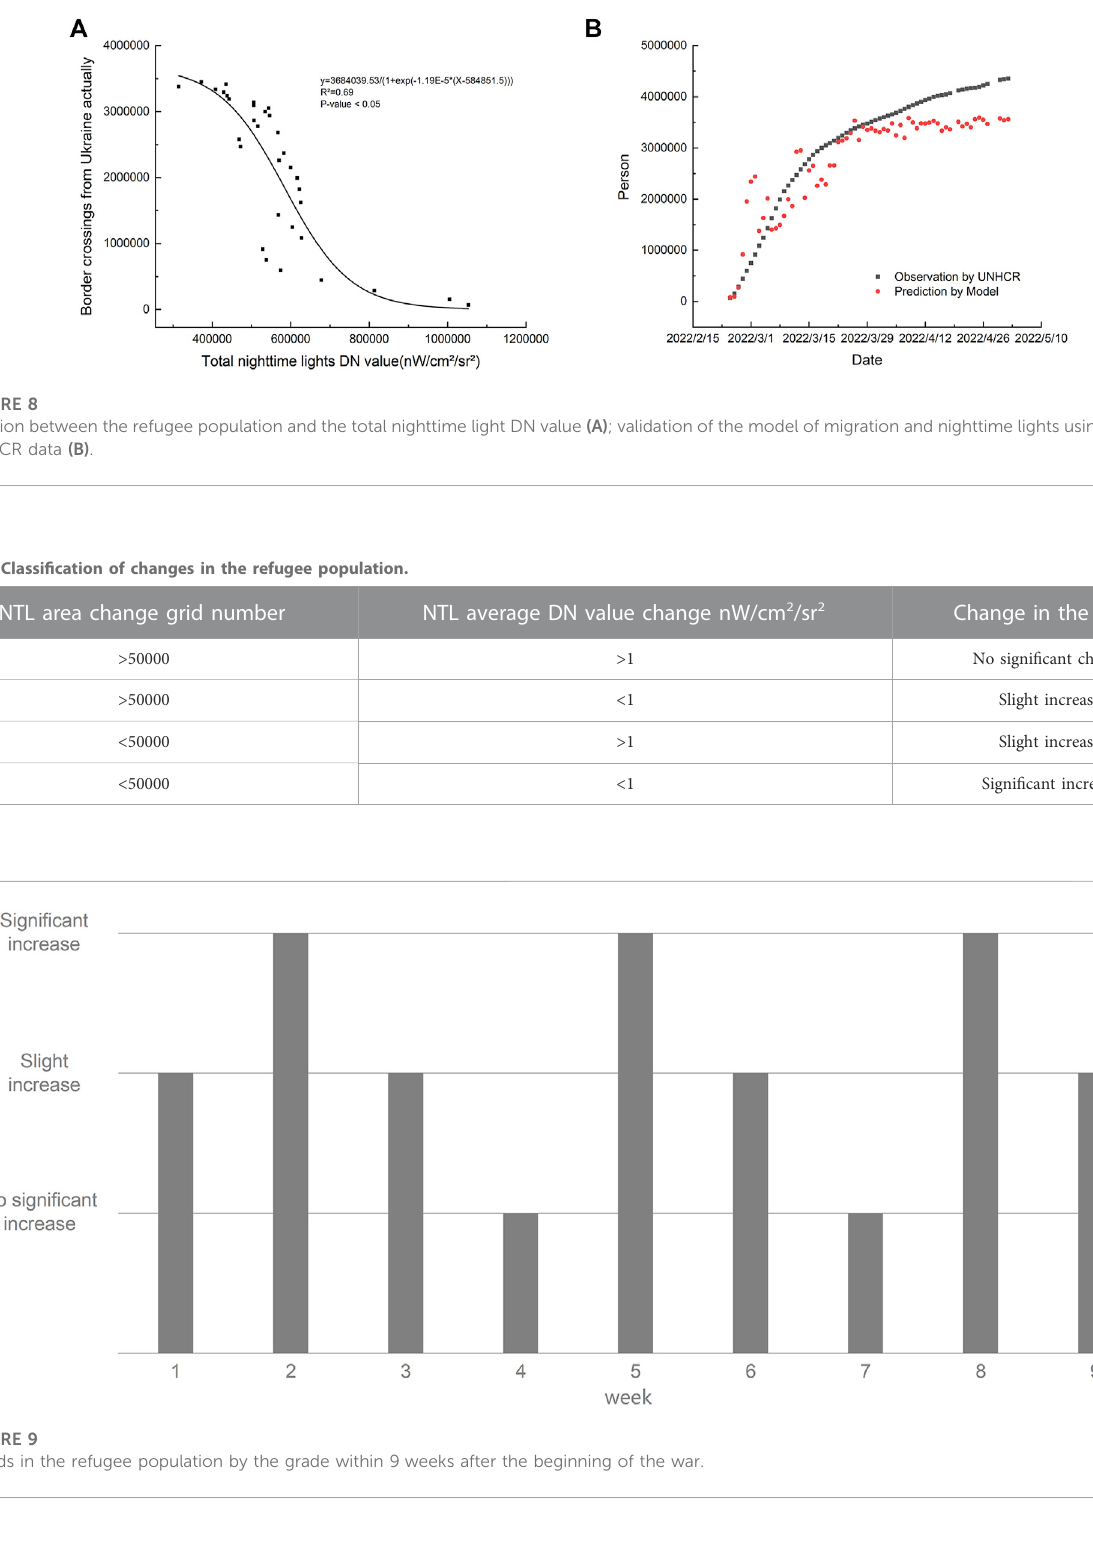
uctuations. Due to the high upper limit of nighttime light data, the